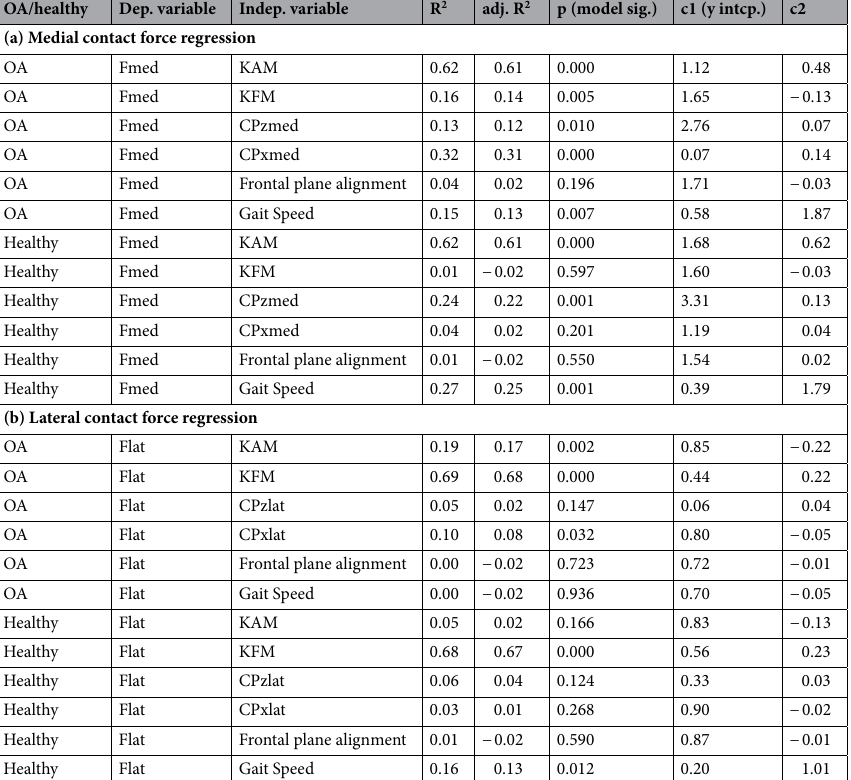
Table 2. Simple regressions models in OA and healthy groups with F med (a) and F lat (b) as dependent variables. The corresponding independent variable (indep. variable), (adjusted) coefficient of determination (adj.) R 2 , model significance p, and the regression coefficient corresponding to the independent variables and the y-intercepts (y intcp.) are given in the table. Independent variables consist of the following parameters: Knee adduction moment (KAM), knee flexion moment (KFM) and medial and lateral contact point locations in the anterior–posterior (CPxmed, CPxlat), and medial–lateral (CPzmed, CPzlat) directions, frontal plane alignment, and gait